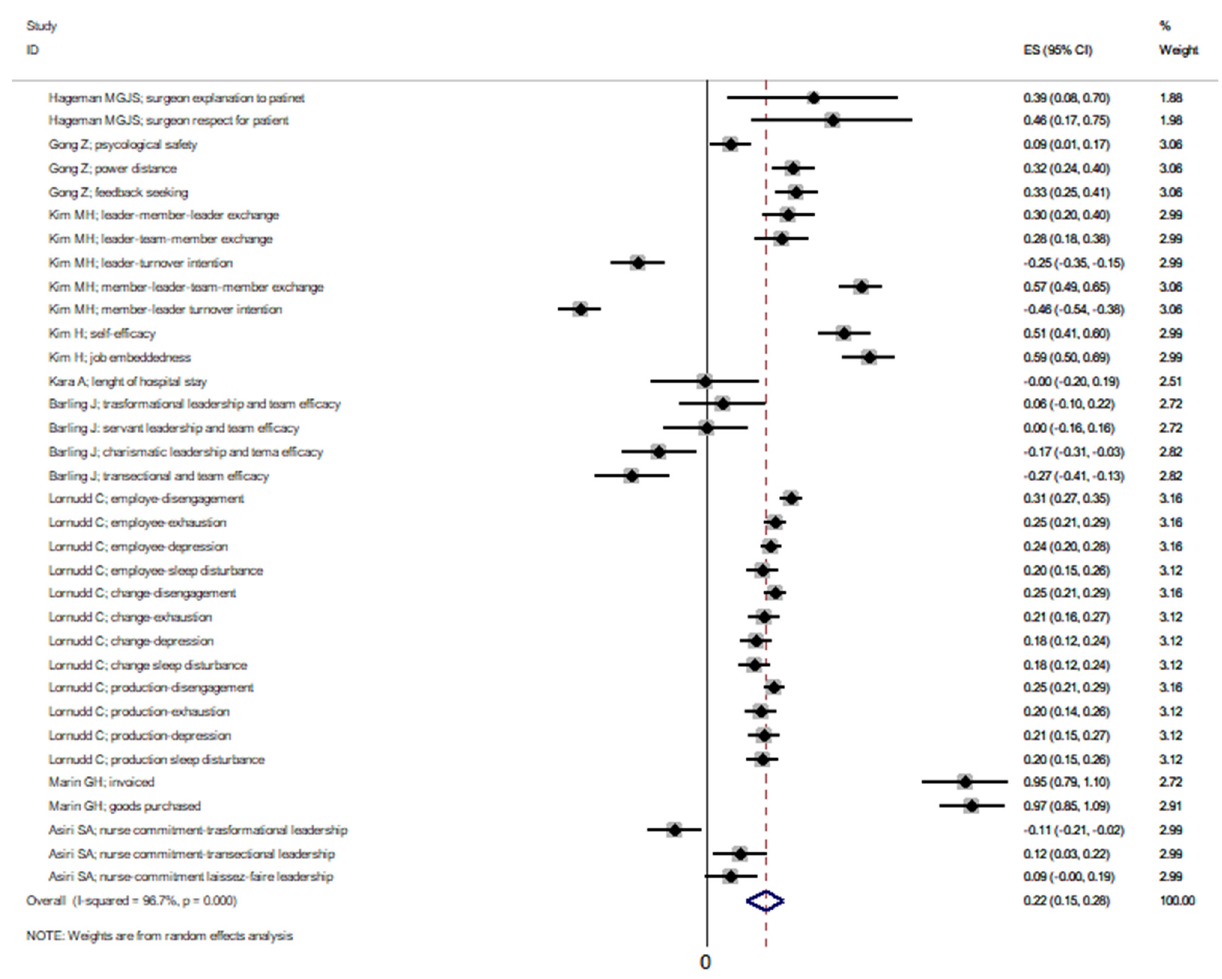
Figure 3. Effectiveness of leadership in cross-sectional studies. Dashed line represents the pooled effectiveness value [30,42–49]. Table 2. Multi-regression analysis of leadership effectiveness in cross-sectional